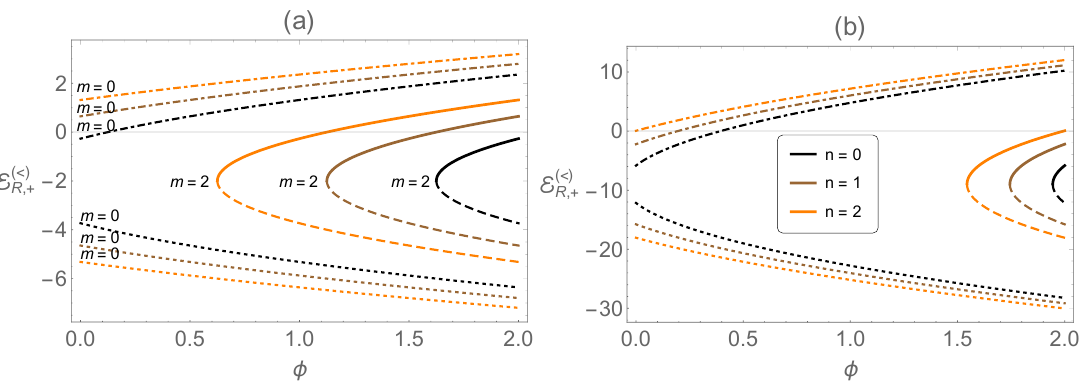
( < ) (Equation (71)) as a function of φ . In ( a ), a = 0.5, α = 0.5 and R , +